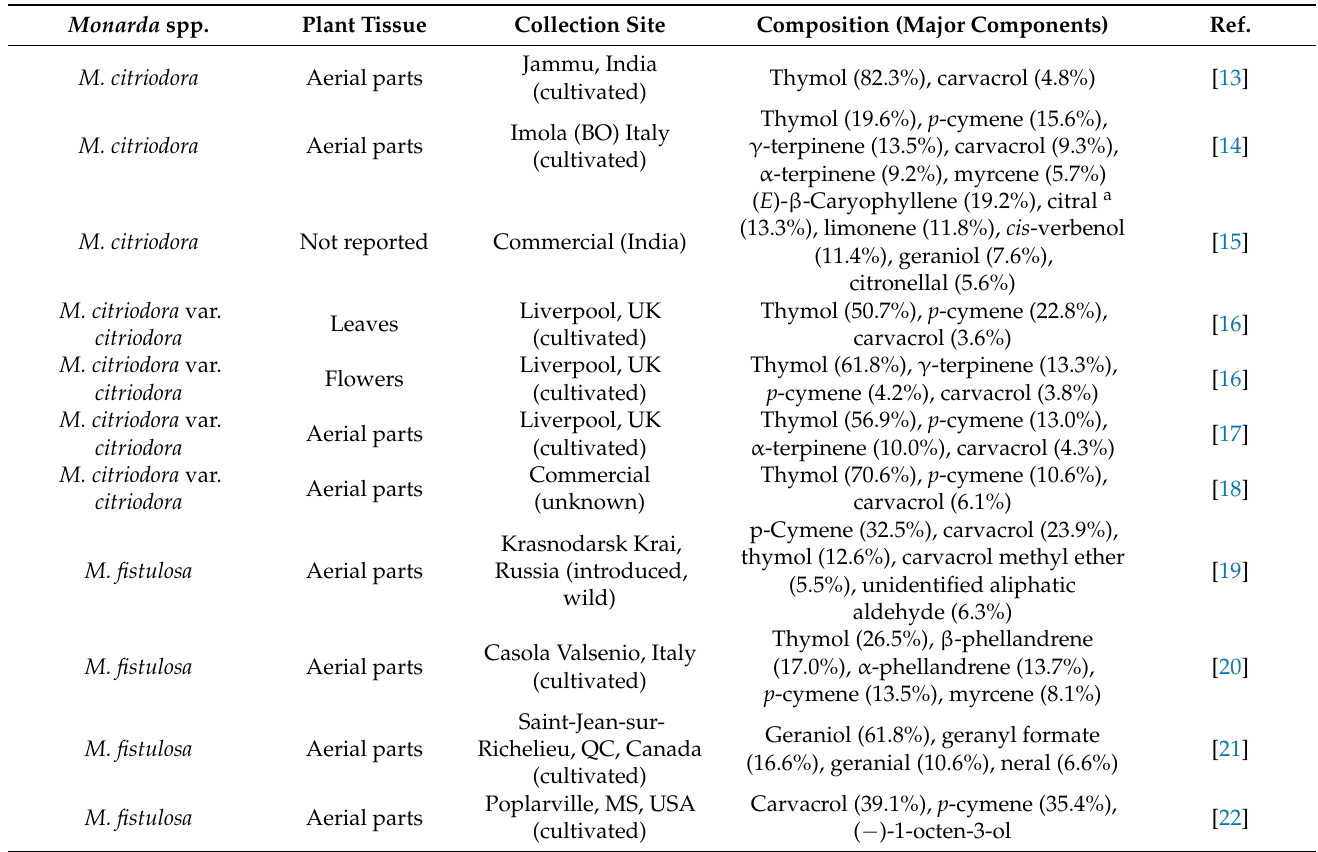
Table 4. Major essential oil components of Monarda species from geographical locations around the world. Monarda